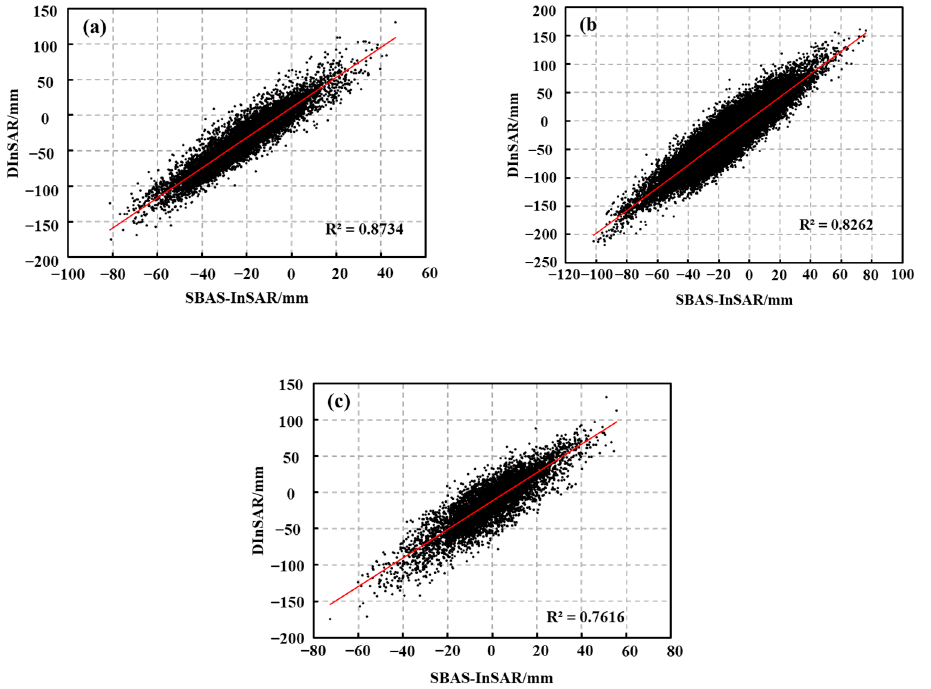
Figure 12. Results of cross-validation of glacier deformation features in the Meili Mountain, ( a ) for the northern melt zone, ( b ) for the central accumulation zone, and ( c ) for the southern melt zone.